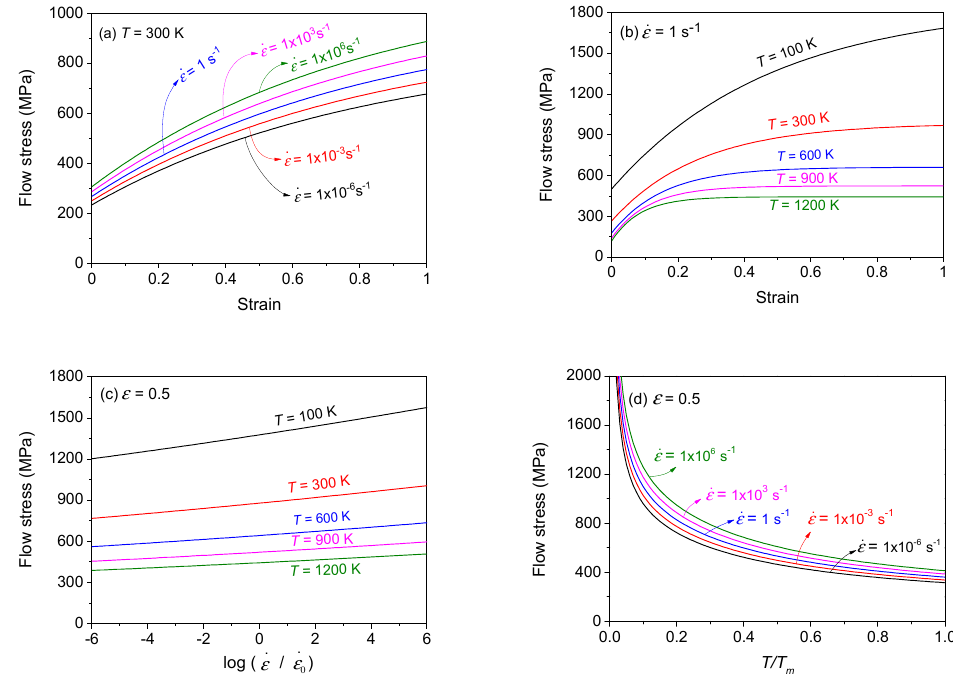
Figure 12. Flow stress–strain curves of SS310 predicted using the LW model ( a ) at 300 K for different strain rates and ( b ) at 𝜀(cid:4662) = 1 for different temperatures. Change in flow stress at 𝜀 = 0.5 ( c ) with log ( 𝜀(cid:4662) / 𝜀(cid:4662) (cid:2868) ) for different temperatures and ( d ) with T / T m for different strain rates ( T m = 1727 K).